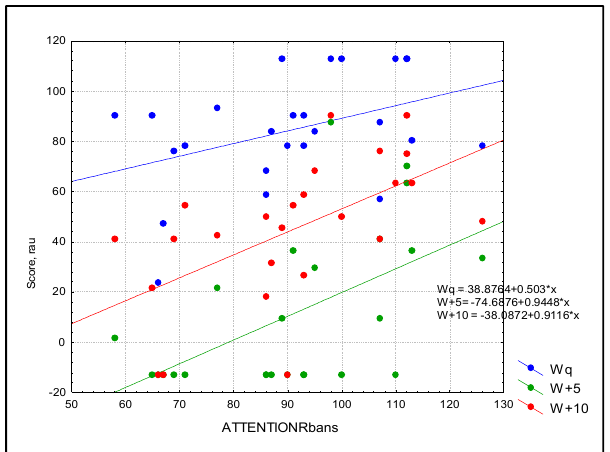
Figure 1. Scatterplot of audiological outcomes for words in three conditions: blue = quiet (Wq), green = SNR = +5 (W+5), and red = SNR+10 (W+10) as predicted by attention in the study sample (n = 30). Simple linear regression based on the RBANS score explained more than 50% of the variance for word recognition in noise.